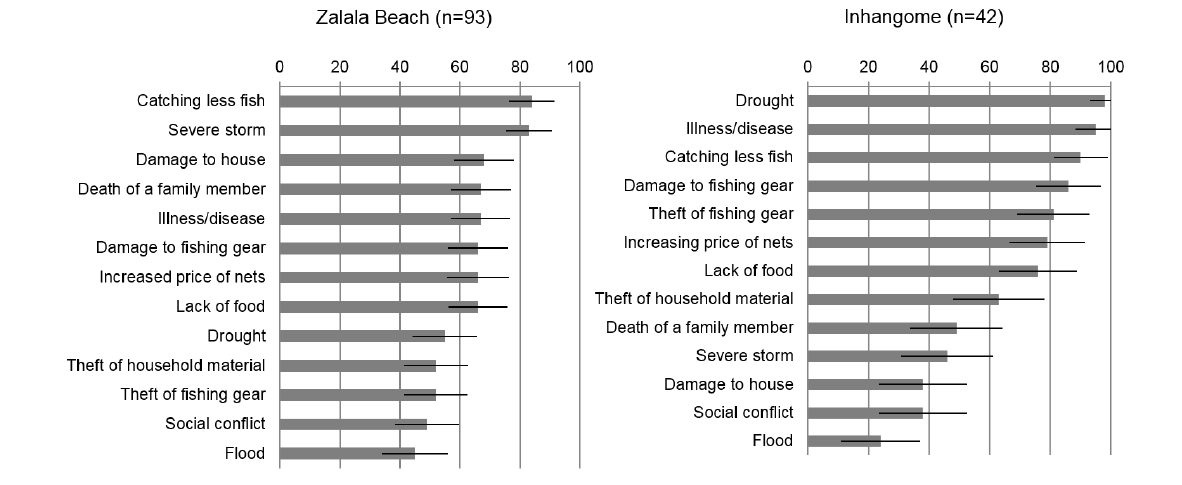
Fig. 2 . Summary of livelihood stressors being experienced in the two research communities. Bars indicate percentage of total respondents (± 95% CI) that experienced each stressor in the previous 12